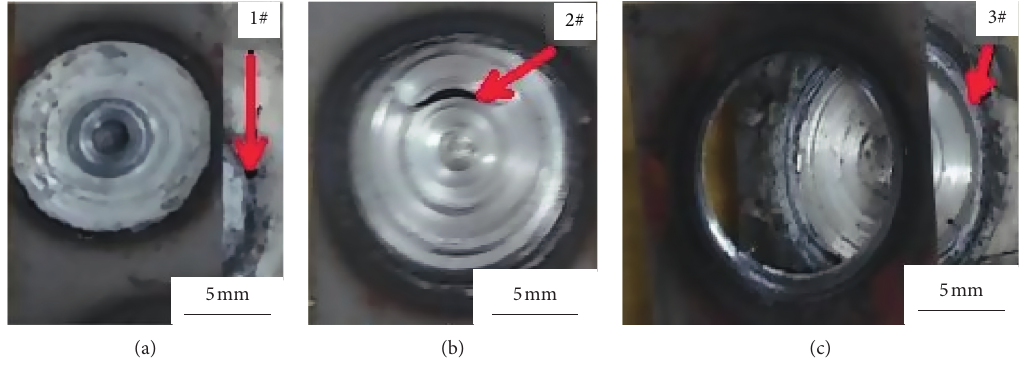
Figure 4: Fracture morphology of 1#, 2#, and 3# sample